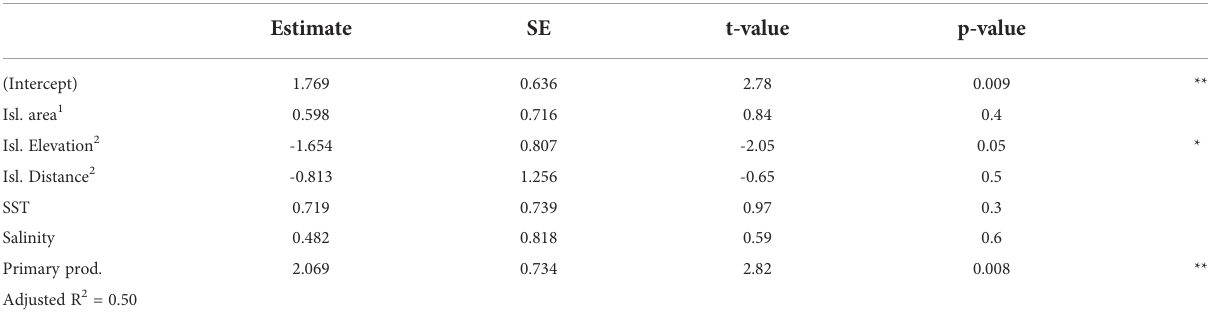
TABLE 1 Results of the linear models testing the effects of environmental variables on seabird trait diversity (Rao ’ s Q and FRic indices). Rao ’ s quadratic entropy (Rao ’ s